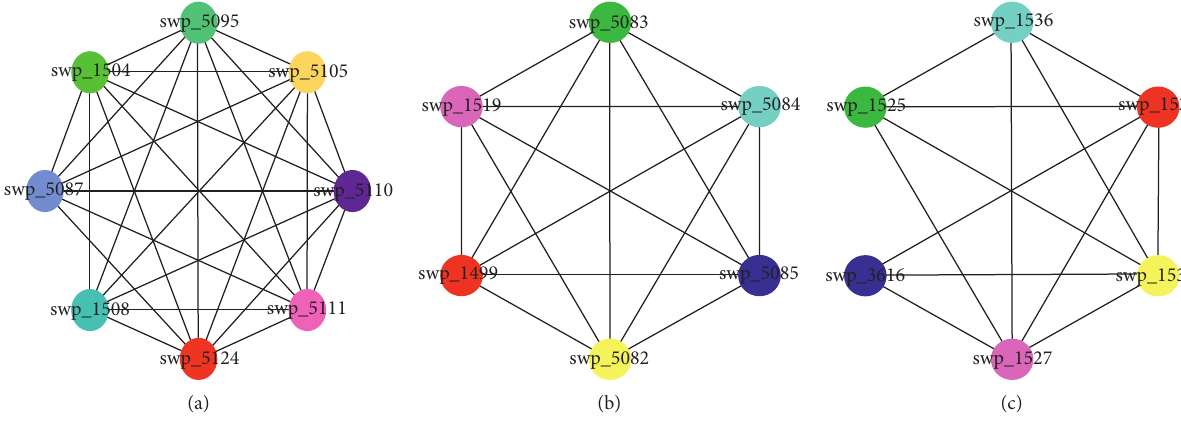
Figure 4: The flagellar assembly module underlying (a) cold shock, (b) heat shock, and (c) high pressure conditions.